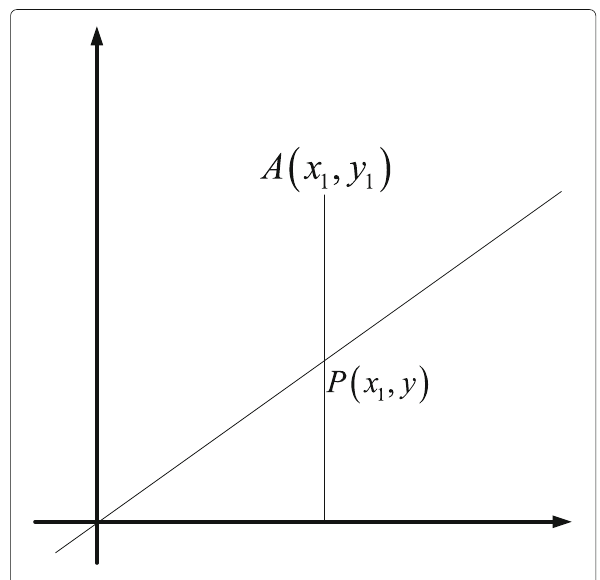
Fig. 10 Position of a point with respect to a